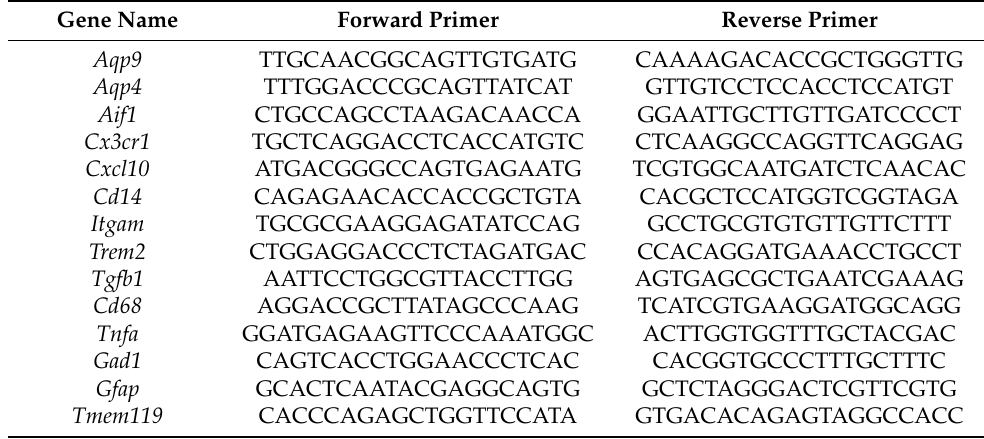
Table 2. Primers used for RT-qPCR